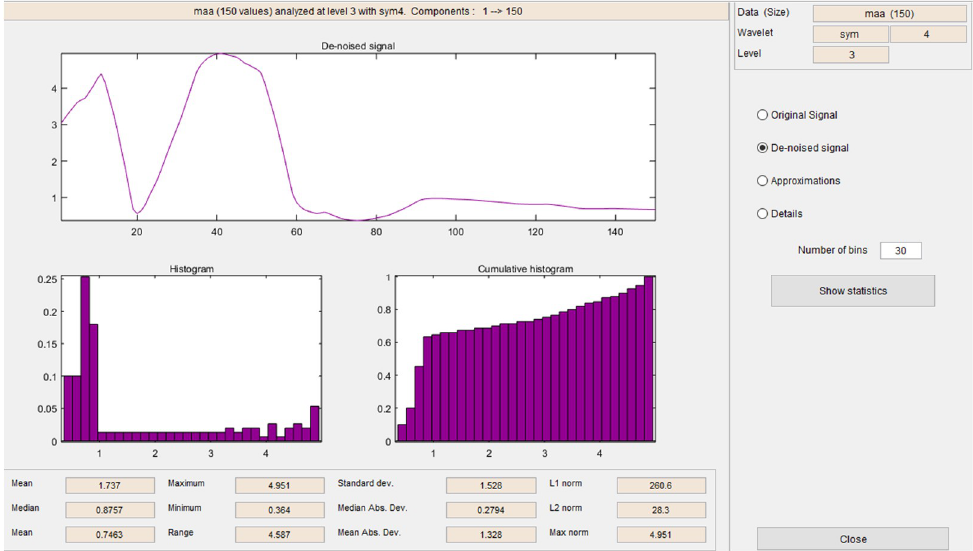
Figure 22. Statistical data of the de-noise signal of the approximation coefficients in level 3 related to the upward-downward movement.